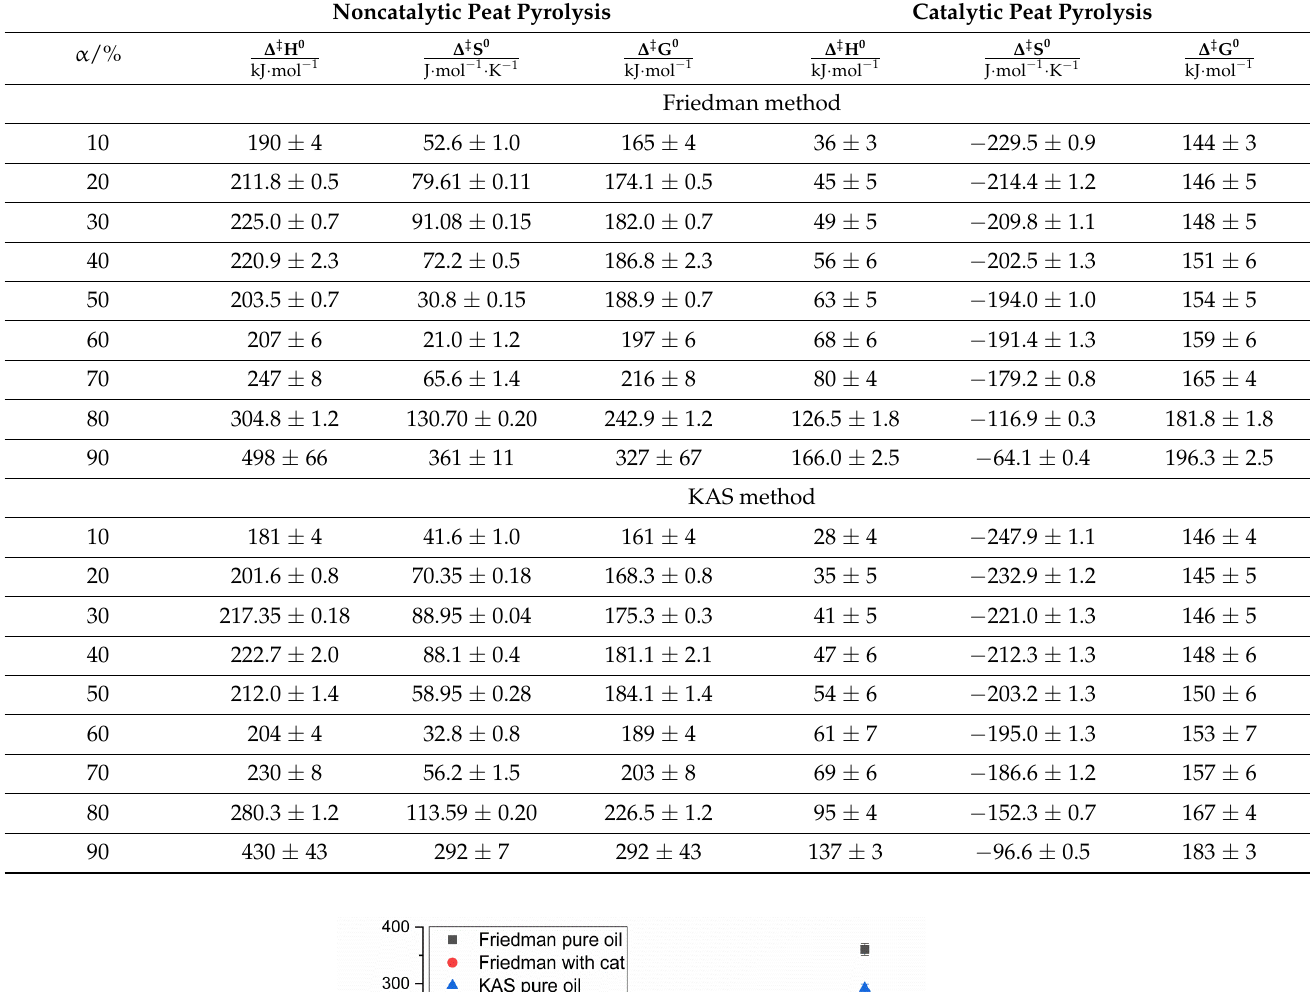
Table 5. Activation thermodynamic parameters for catalytic and non-catalytic pyrolysis process based on KAS and Friedman methods.